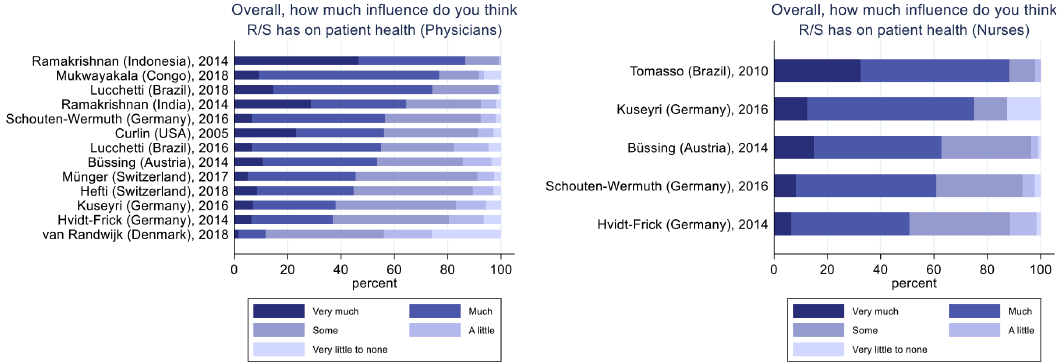
Figure 1. Physicians ' and nurses ' opinion about the influence of R/S on patient health. Physicians, N = 3,700. Nurses, N = 1,020.